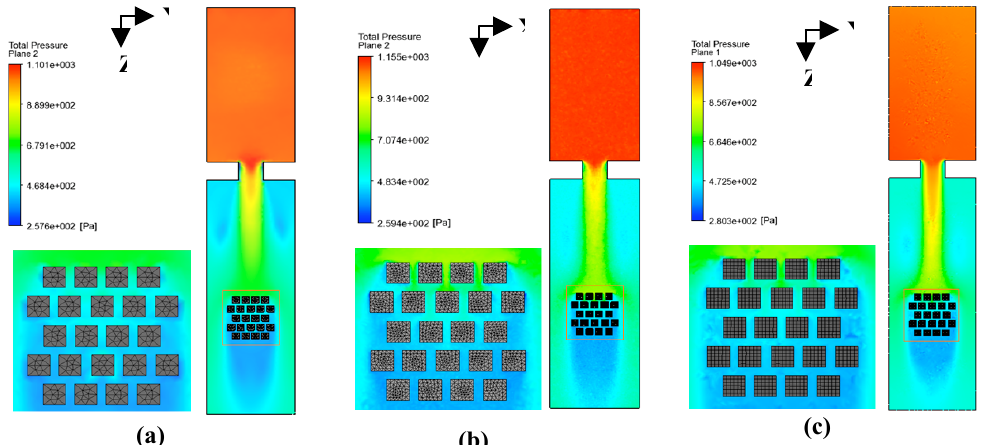
Fig. 7. Pressure field calculated for the three kinds of mesh in the ZX plan. (a)Unstructured tetrahedral volume mesh with inflation; (b) Unstructured tetrahedral volume mesh with refinement; (c) Structured hexahedral volume mesh